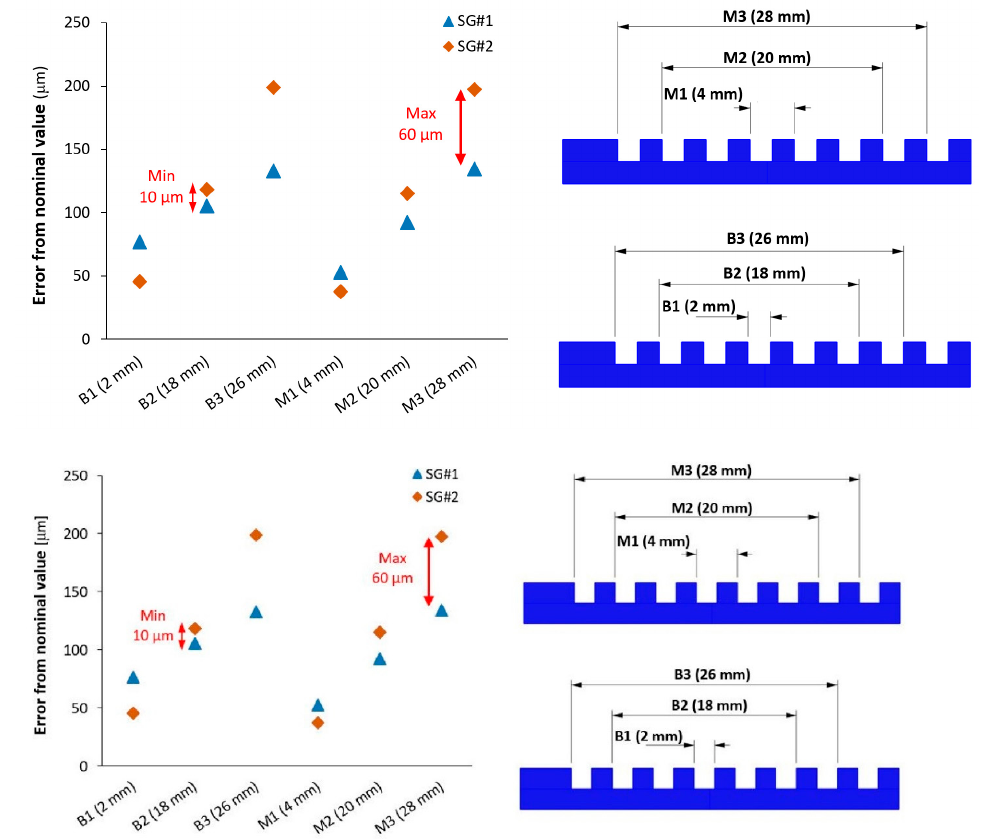
Figure 15. Differences between the two step gauges considering errors with respect to the Computer Aided Designed (CAD) dimensions.